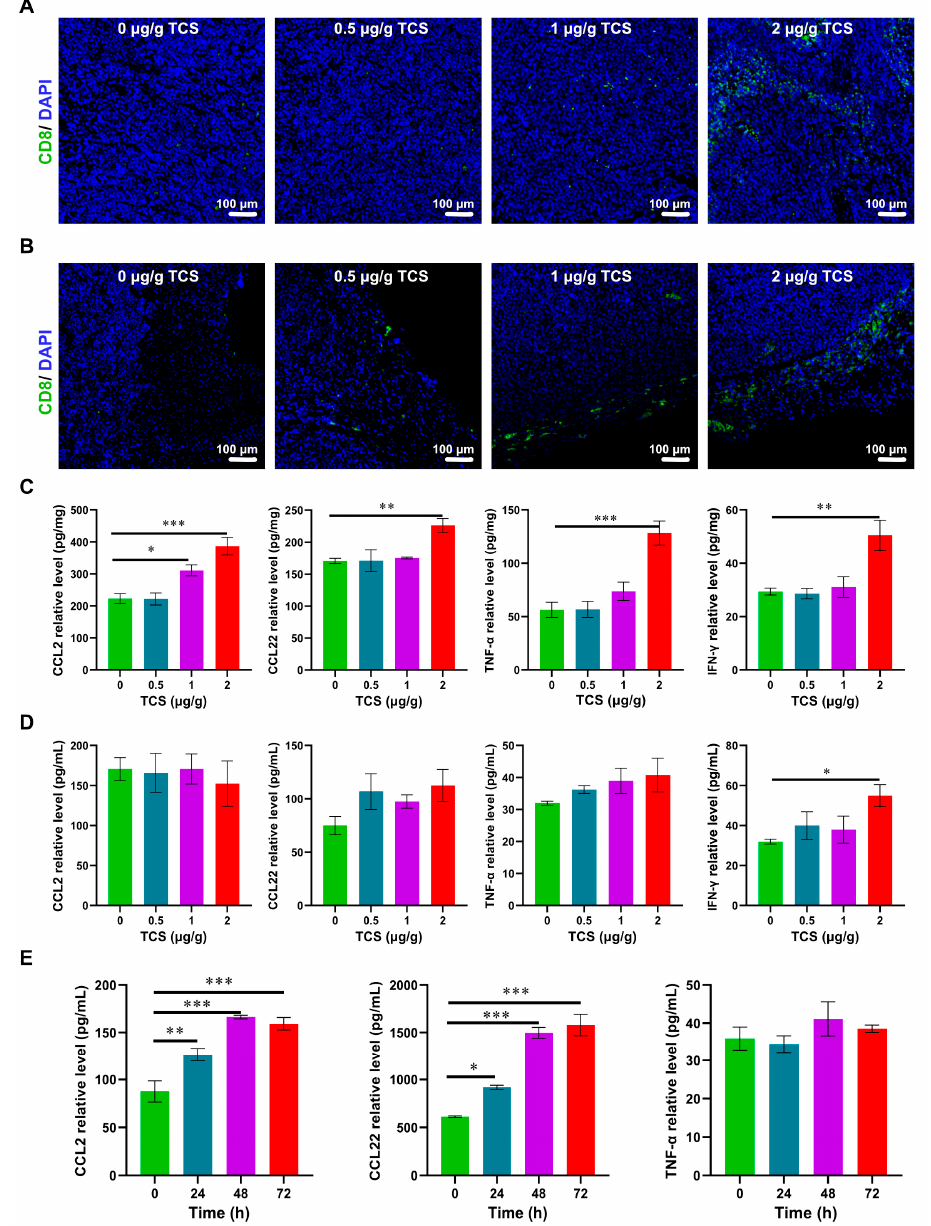
Figure 5. Effects of TCS on chemotactic enrichment. ( A ) Immunofluorescence method detected CD8-positive cells in the center of HCC tissues. Bar = 100 μ m; ( B ) Immunofluorescence method detected CD8-positive cells at the edge of HCC tissues. Bar = 100 μ m; ( C ) ELISA method detected the protein levels of CCL2, CCL22, TNF- α and IFN- γ in HCC tissues treated with different doses of TCS (0, 0.5, 1 and 2 μ g/g); ( D ) ELISA method detected the protein levels of CCL2, CCL22, TNF- α and IFN- γ of mouse serum; ( E ) ELISA method detected the protein levels of CCL2, CCL22 and TNF- α in H22 HCC cells treated with 25 µ g/g TCS after 24 h, 48 h and 72 h, GAPDH as the internal reference gene. *, p < 0.05; **, p < 0.01; ***, p <